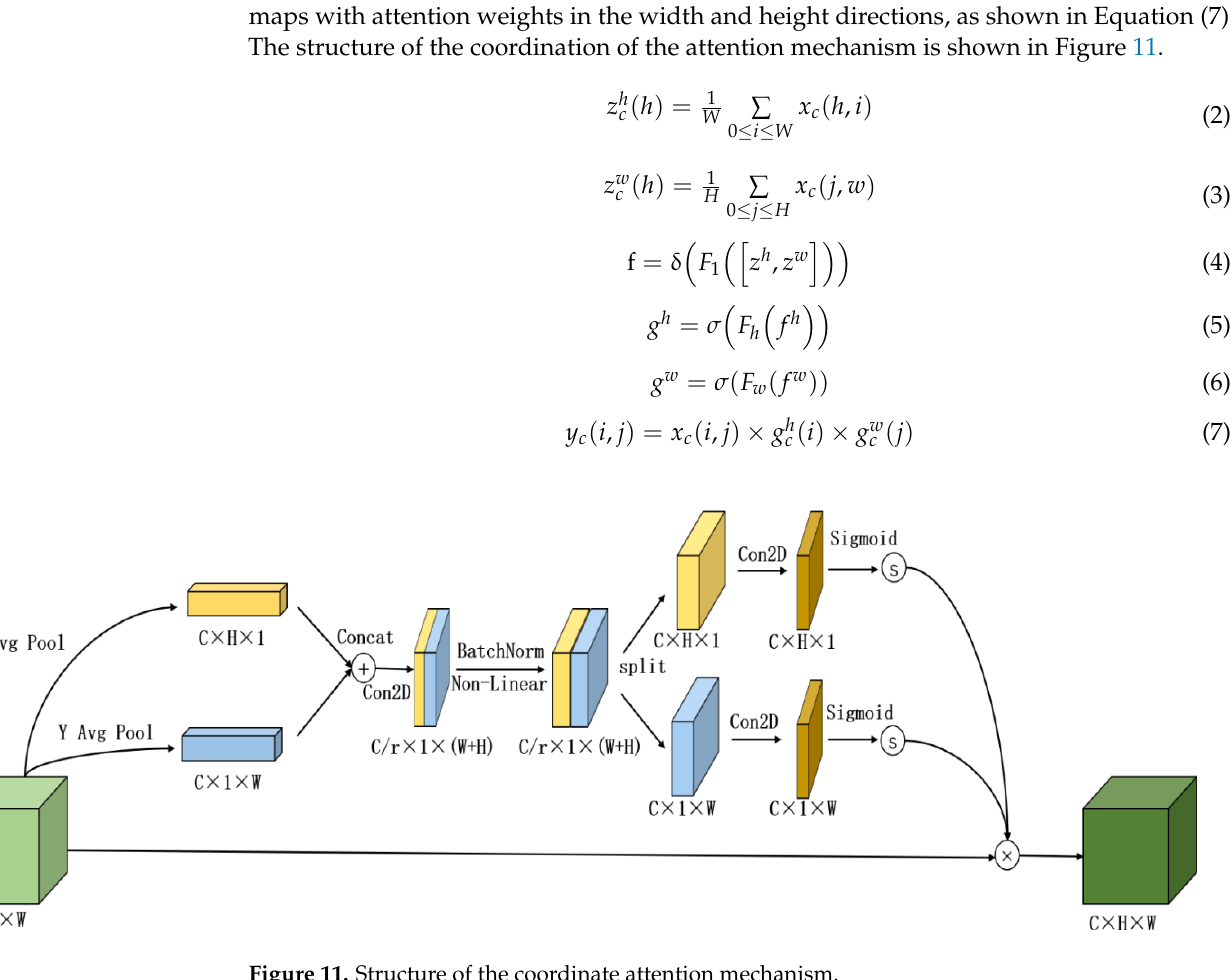
Figure 11. Structure of the coordinate attention